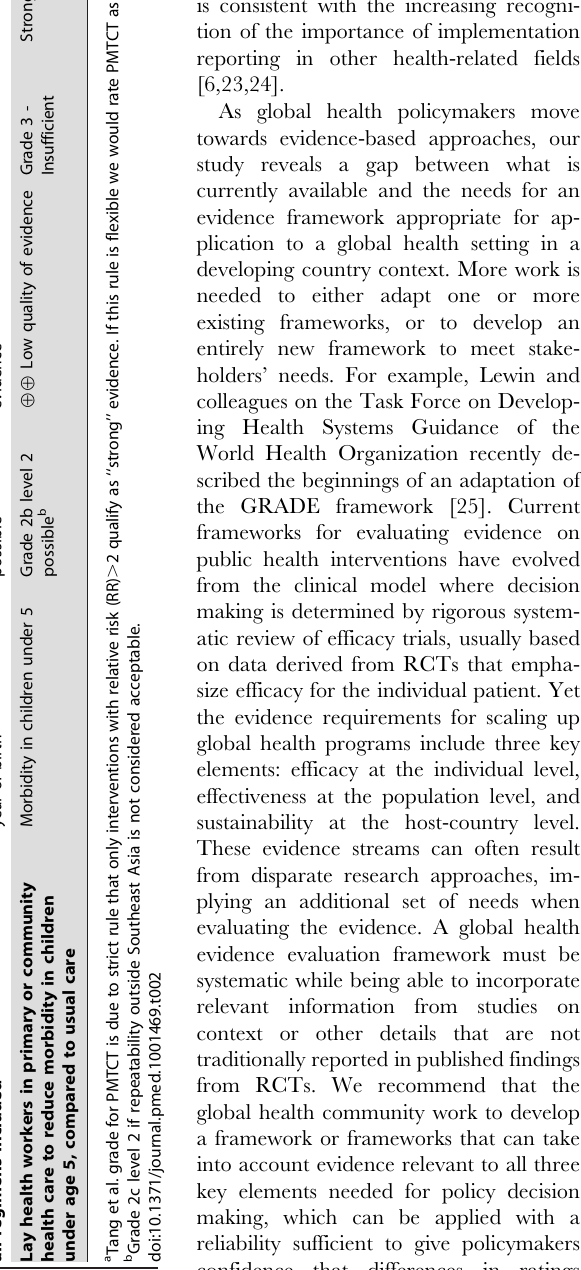
interventions across key dimen- sions.